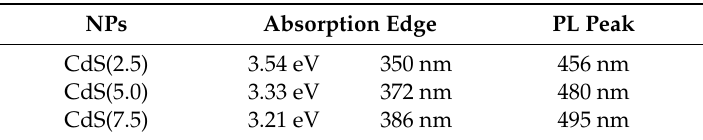
Table 2. Absorption edge and photoluminescence peak of the CdS nanoparticles synthesized by 2.5, 5.0, and 7.5 milliliters of sulphur per gram of cadmium thiolate.